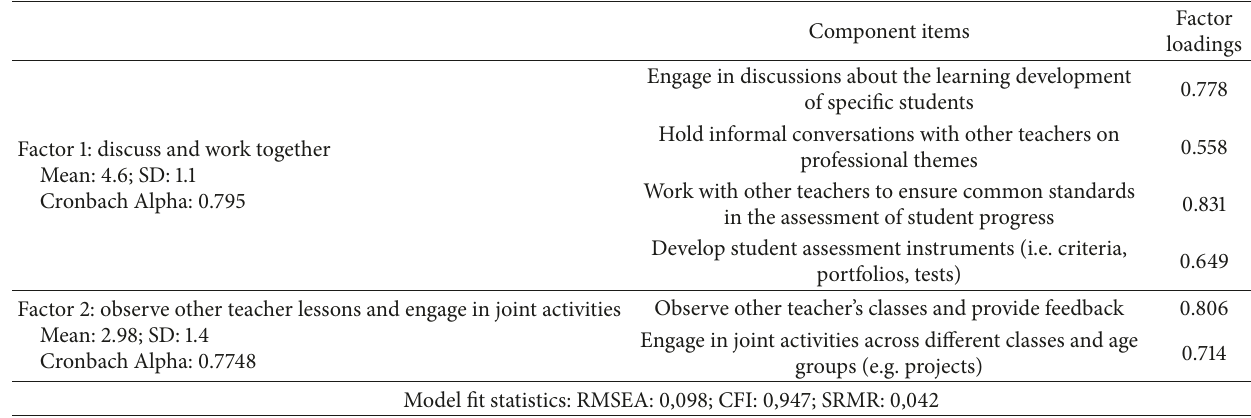
Table 3: Professional interchange within schools as reported by teachers (1 = never; 2 = once a year or less, 3 = 2–4 times a year; 4 =